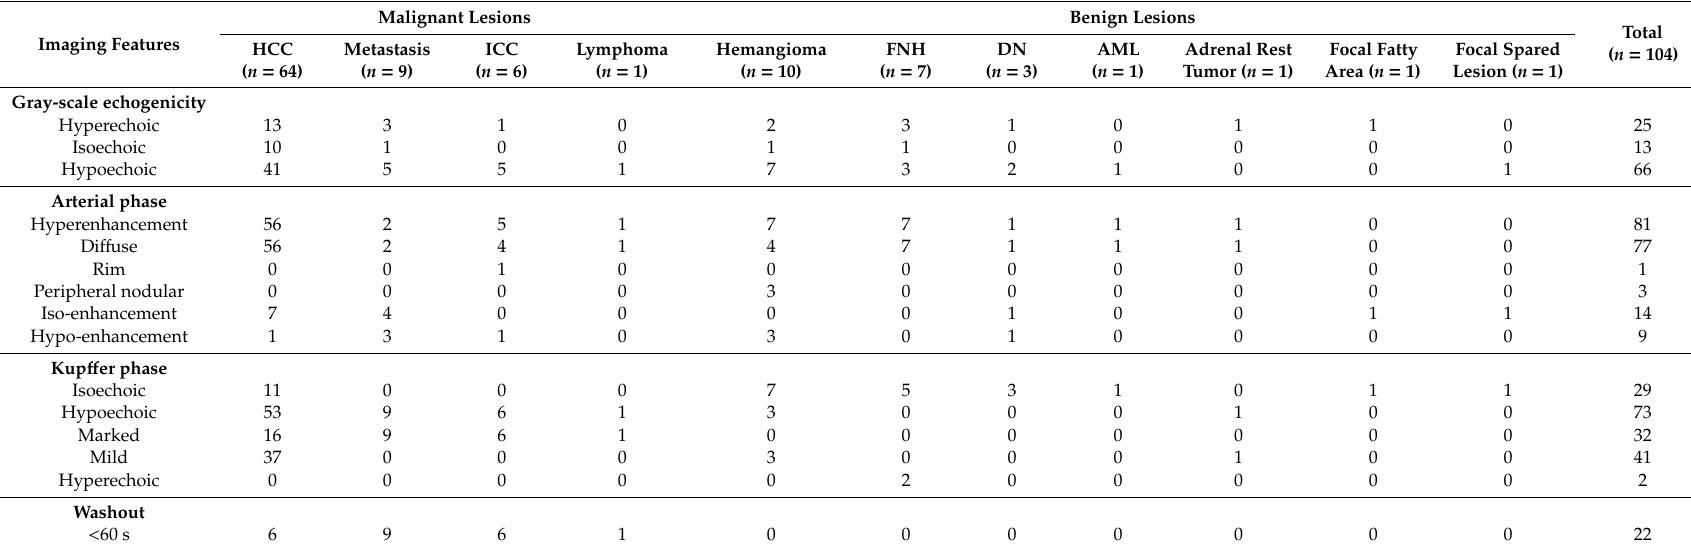
Table 5. Imaging characteristics of all liver